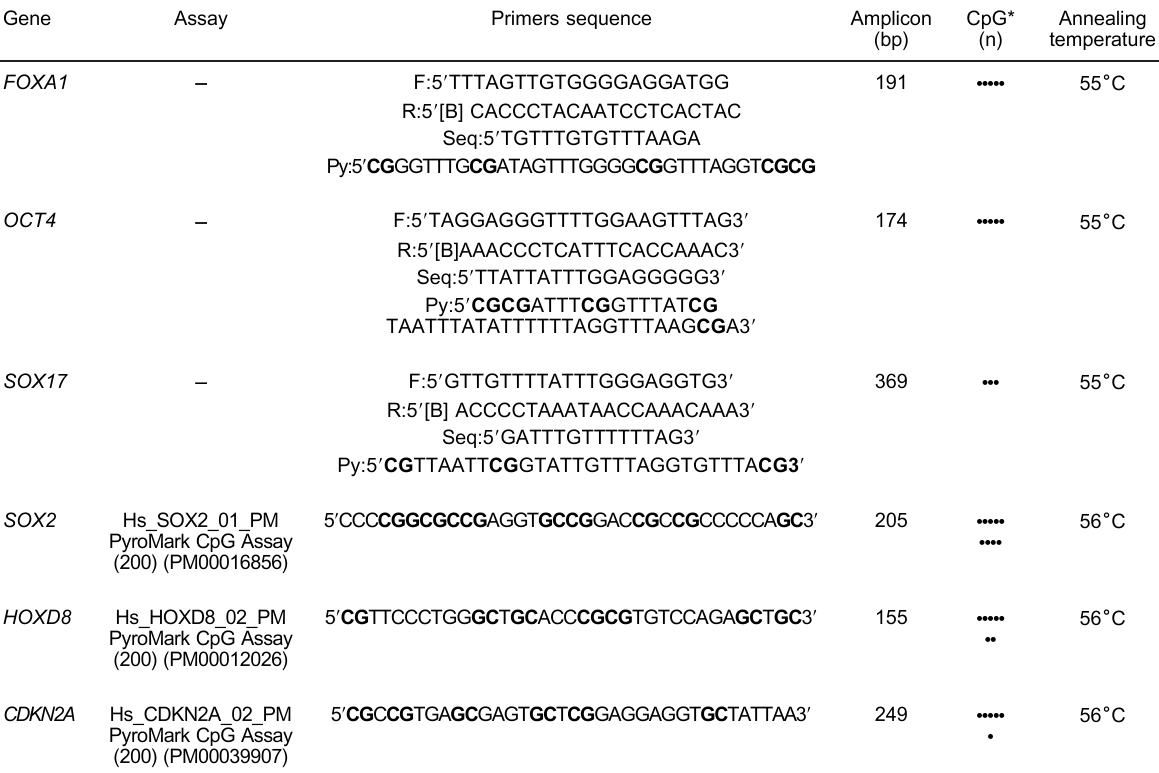
Table 1. Primer sequences and the properties of the genes assessed by pyrosequencing. Gene